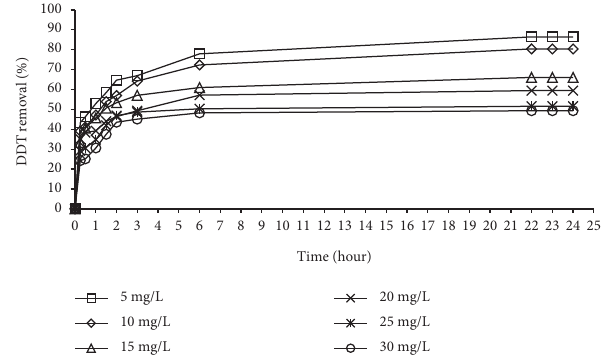
Figure 10: Percentage removal of DDT by CSAC versus time at various initial concentrations (solution temperature of 30 ° C, ad- sorbent dose of 0.2g solution volume of 200mL, and solution pH of